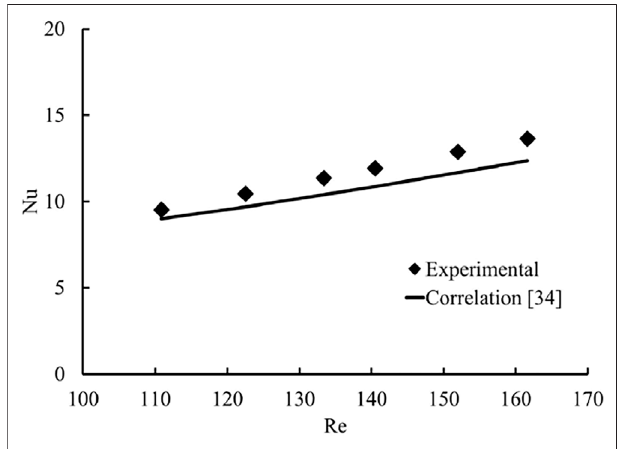
FIGURE 2 | Validation of the experimental